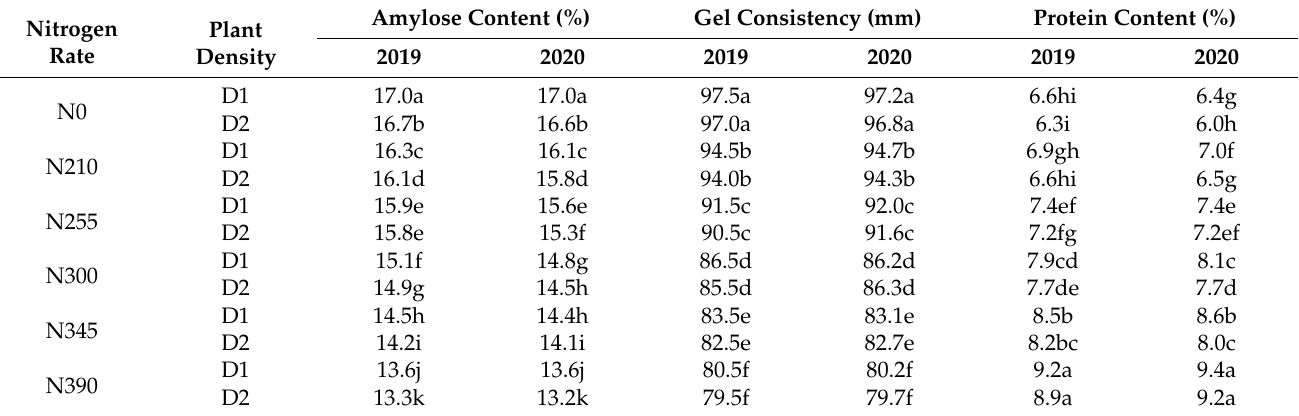
Table 6. Grain nutritive quality under combined nitrogen rate and planting density in saline soil.